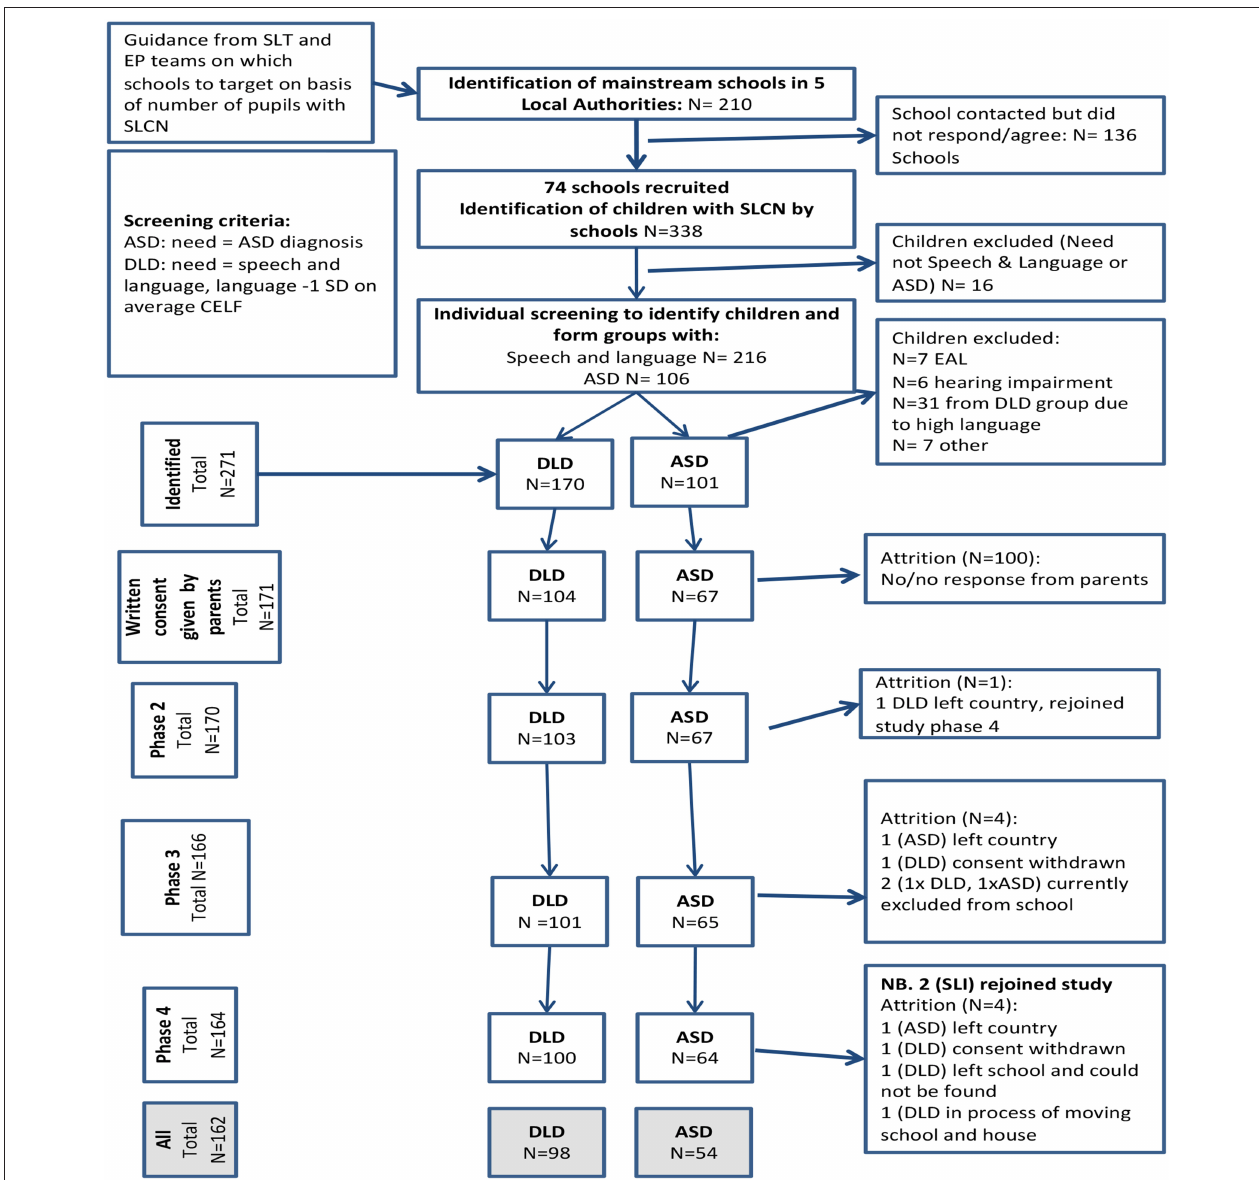
FIGURE 1 | Flow diagram showing inclusion criteria, exclusion criteria and attrition in the